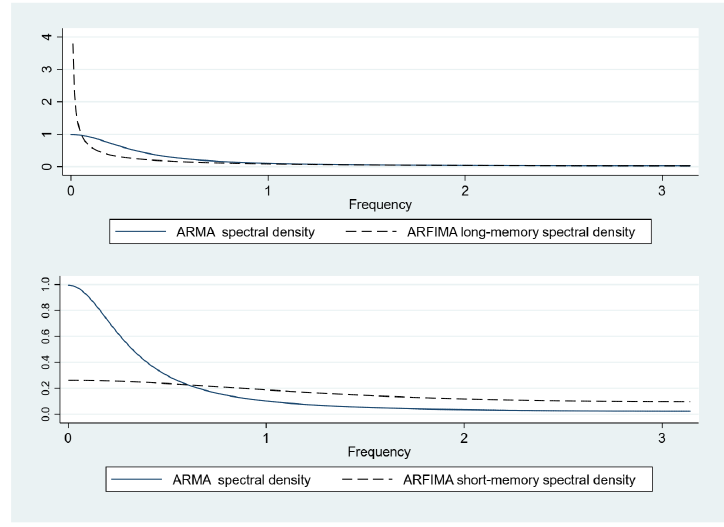
Figure 3. ARMA and ARFIMA implied spectral densities.